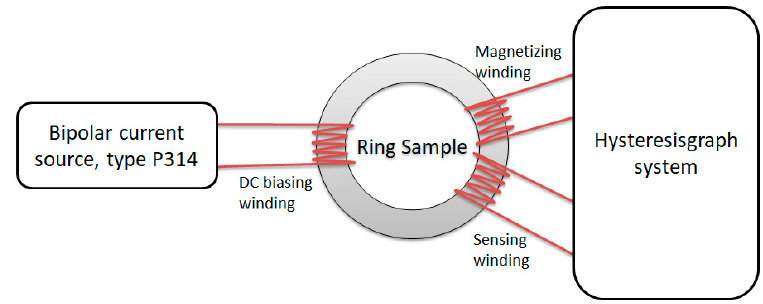
Figure 1. Schematic diagram of measurement test stand.